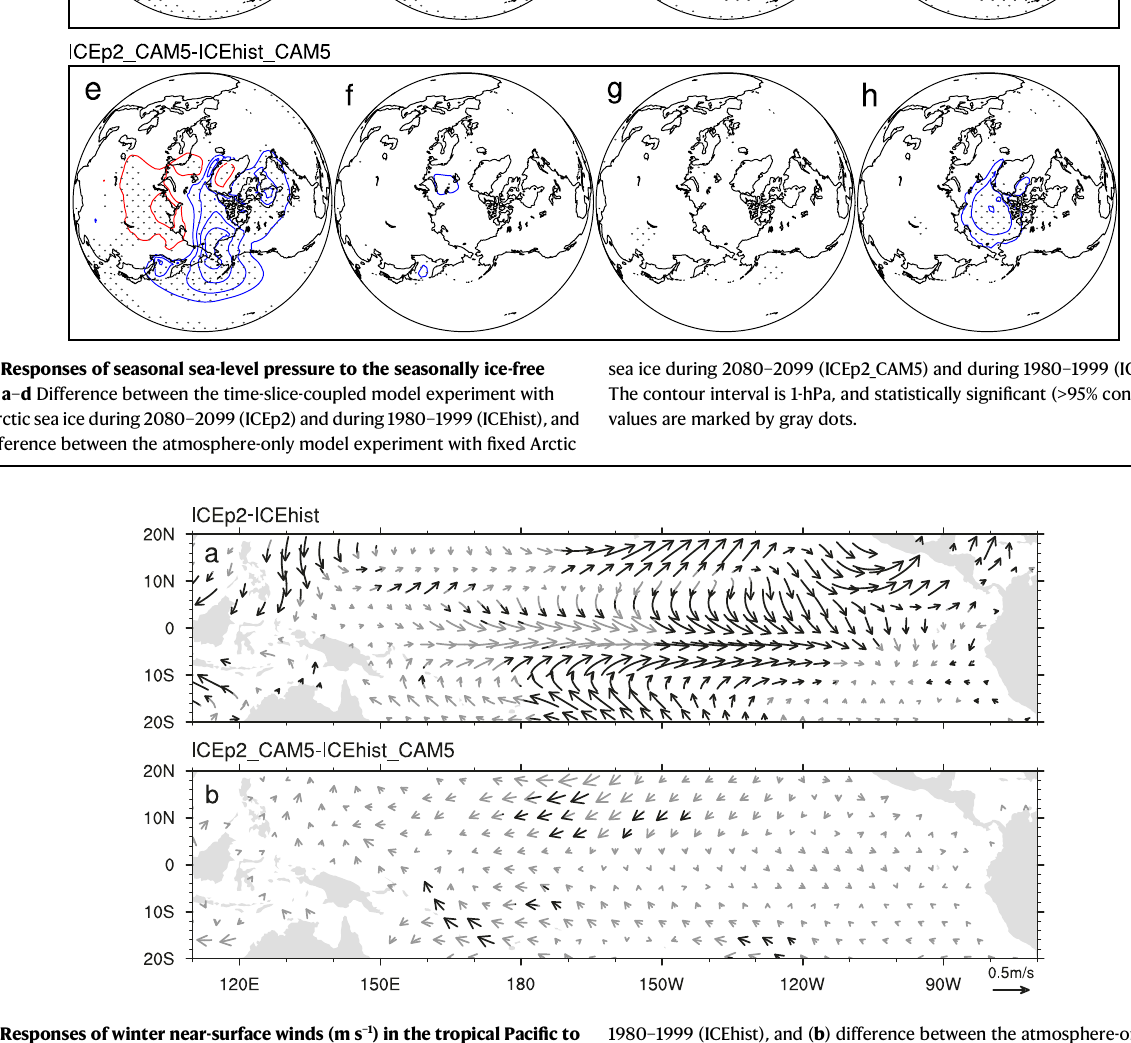
1980 – 1999 (ICEhist), and ( b ) difference between the atmosphere-only model experiment with fi xed Arctic sea ice during 2080 – 2099 (ICEp2_CAM5) and during 1980 – 1999 (ICEhist_CAM5).